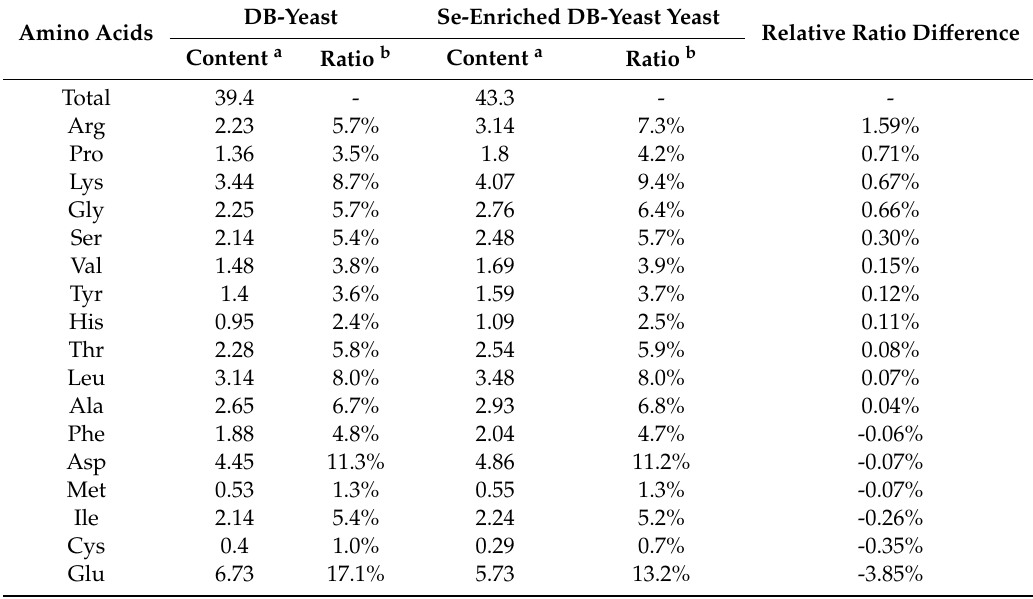
Relative Ratio Di ff erence